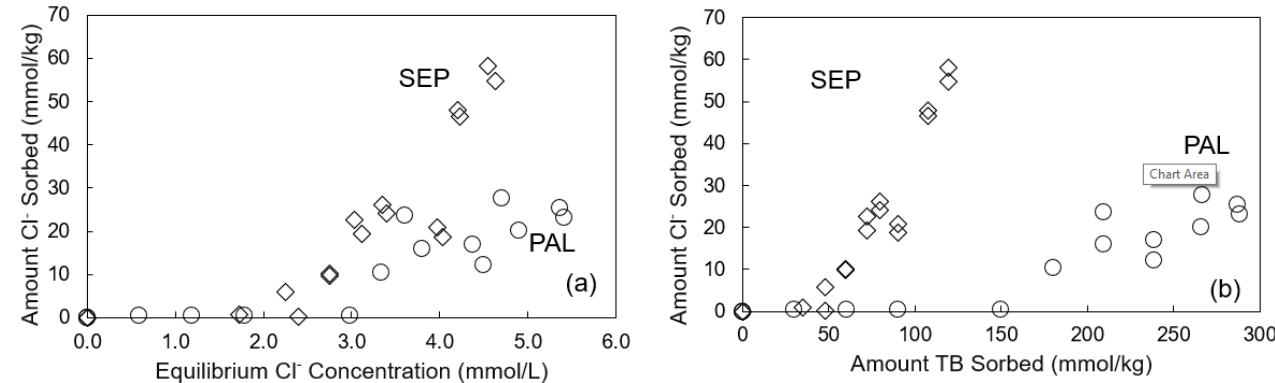
Figure 3. Uptake of counterion Cl – accompanying TB sorption on PAL and SEP ( a ) and relationship between counterion Cl – sorbed against TB sorbed ( b ).